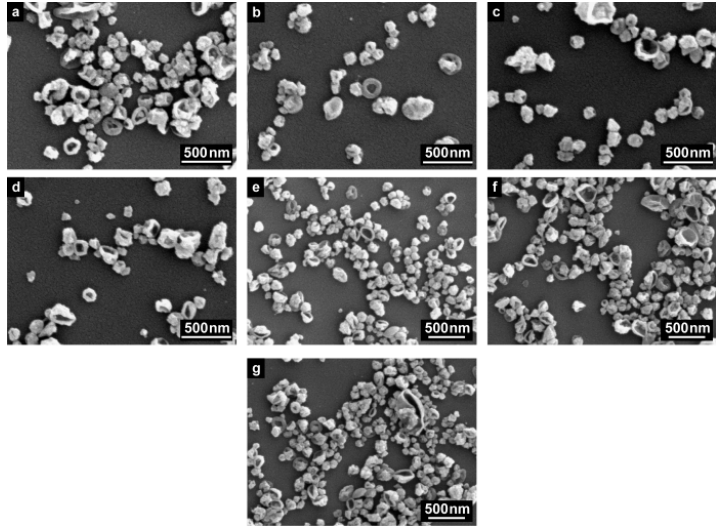
Figure 10. SEM images of MNPs-IL-C 4 @PU NCs. ( a ) 1% (PU-15a), ( b ) 2% (PU-15b), ( c ) 3% (PU-15c), ( d ) 5% (PU-15d), ( e ) 7% (PU-15e), ( f ) 9% (PU-15f), and ( g ) 11% (PU-15g) of encapsulated MNPs-IL-C 4